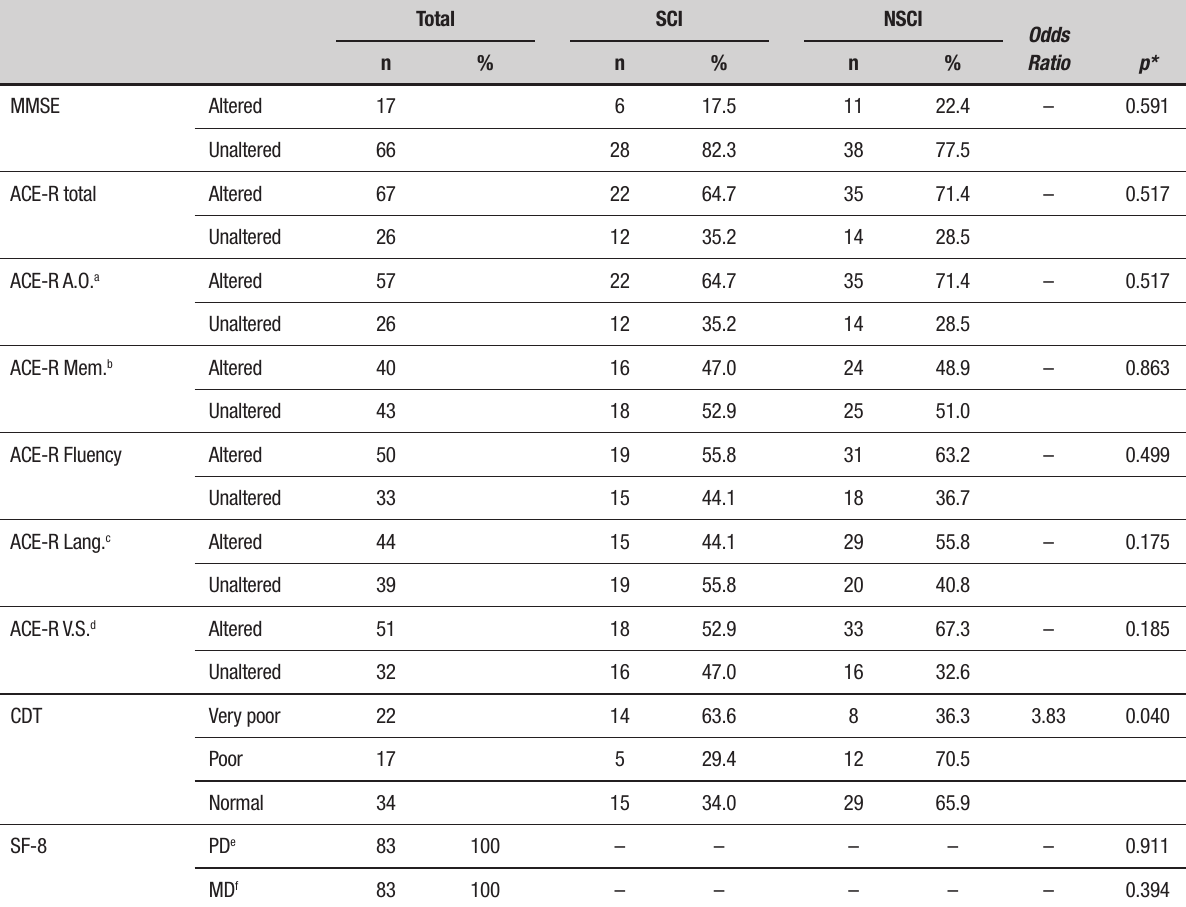
Table 2. Results of the associations between instruments used and MCS-A, by group.